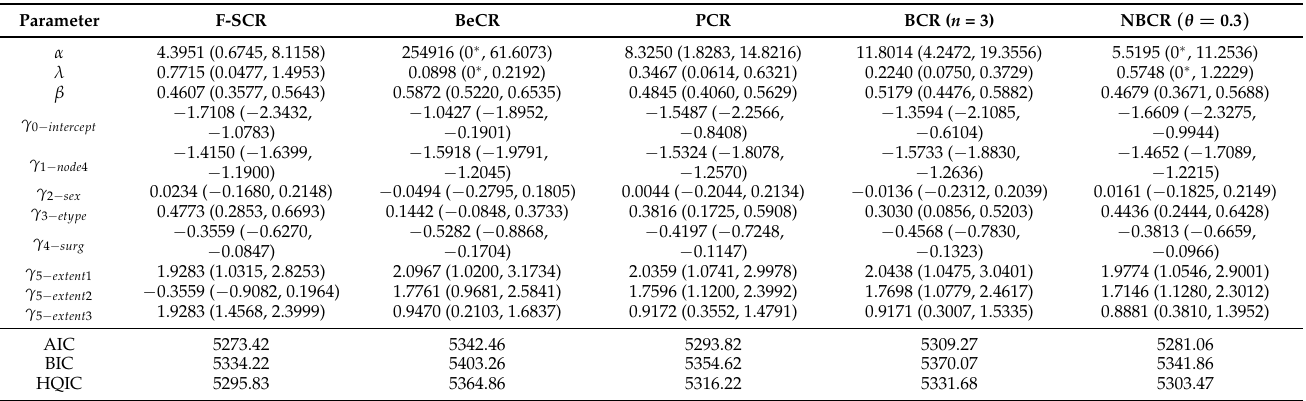
Table 1. ML estimators (95% confidence intervals) and information criteria for the colon cancer data set based on GeTNH distribution.